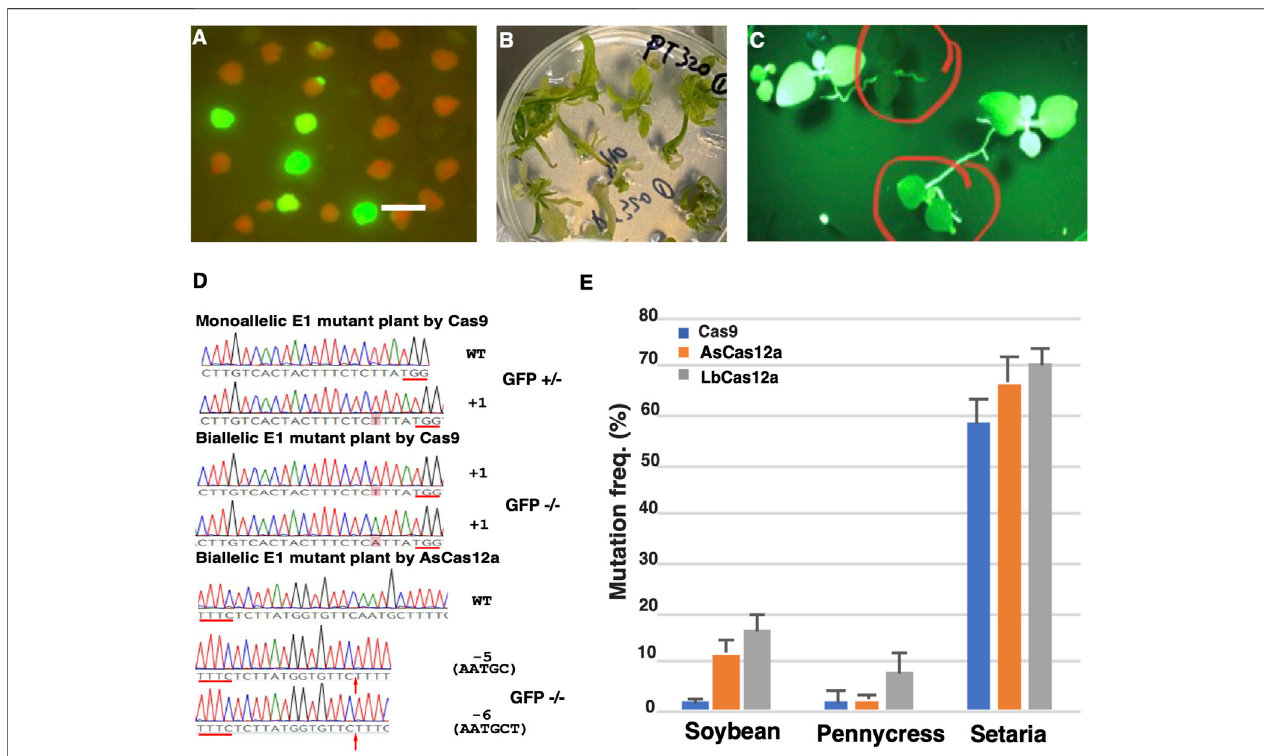
FIGURE 3 | Heritable mutations induced by CRISPR/Cas RNPs in the regenerated E0 calli and E1 plants. (A) GFP negative calli with the high frequency visualized under GFP channel. Scale bar: 1 cm. (B) E0 plantlets regenerated from RNP transfected protoplasts. (C) GFP knock-out plants in E1 progeny. Bi-allelic or mono-allelic mutantplantsare indicated inthe red circles witheither complete loss or reduced intensity ofgreen fl uorescence, respectively. (D) Mutation pro fi les oftheE1plants with GFP negative and semi-negative phenotypes. Insertion or deletion mutations in the targeted sequences are shown in the chromatogram snapshots from Sanger sequencing. The nucleotides from insertions are shaded in red. The break point of each deletion is indicated by the red arrow with the deleted nucleotides shown in parentheses. The PAM sequences of each targeted site are underlined with the red lines. The corresponding phenotype for each E1 plant is shown as either GFP negative (GFP − / − ) or semi-negative (GFP +/-). (E) Cas 9 and Cas12a RNPs induced ef fi cient mutagenesis in the protoplasts from diverse plant species. Mutation frequencies ( Y axis) induced by SpCas9_WT (blue), AsCas12a_Ultra (orange) and LbCas12a_V4 RNPs (grey) are shown in soybean, pennycress and S. viridis ( X axis). The error bars represent the standard deviations from 3 replicates in each RNP transfection experiment. The transfections with gRNA and nuclease alone were conducted as negative controls. No editing above sequencing background noise was found in the negative controls.